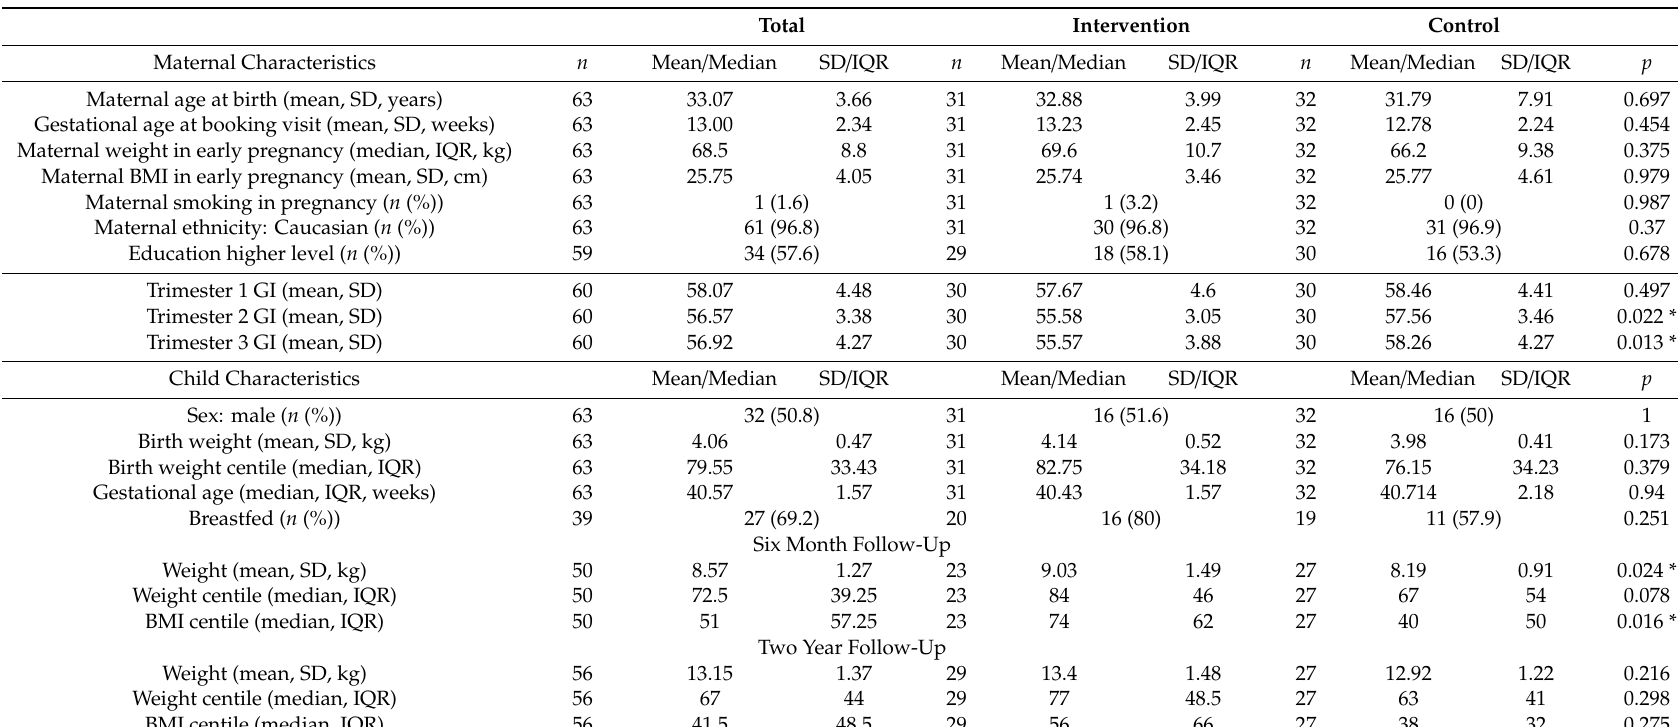
Table 1. Characteristics of the mothers and o ff spring (up to two years of age) of the intervention and control groups in the ROLO cohort. Total Intervention Control Maternal Characteristics n